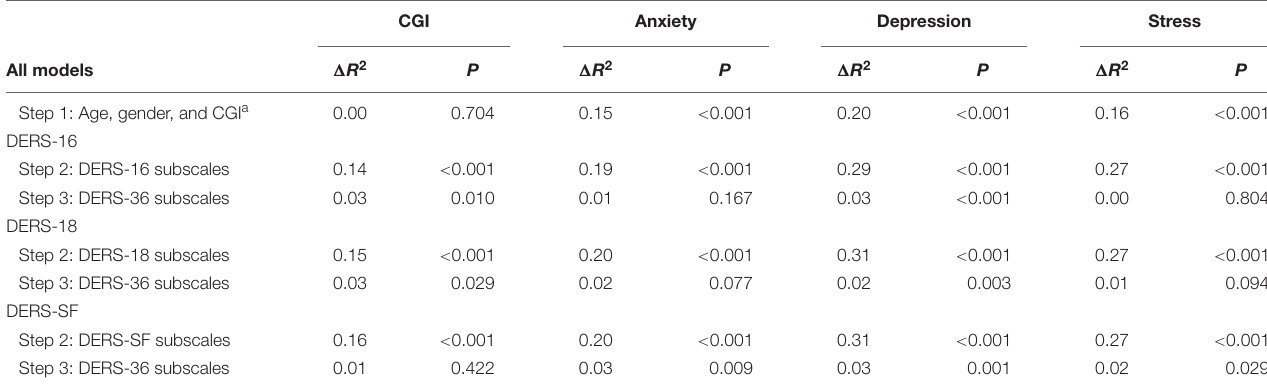
TABLE 4 | Incremental utility of the DERS-16, DERS-18, and DERS-SF. CGI Anxiety Depression